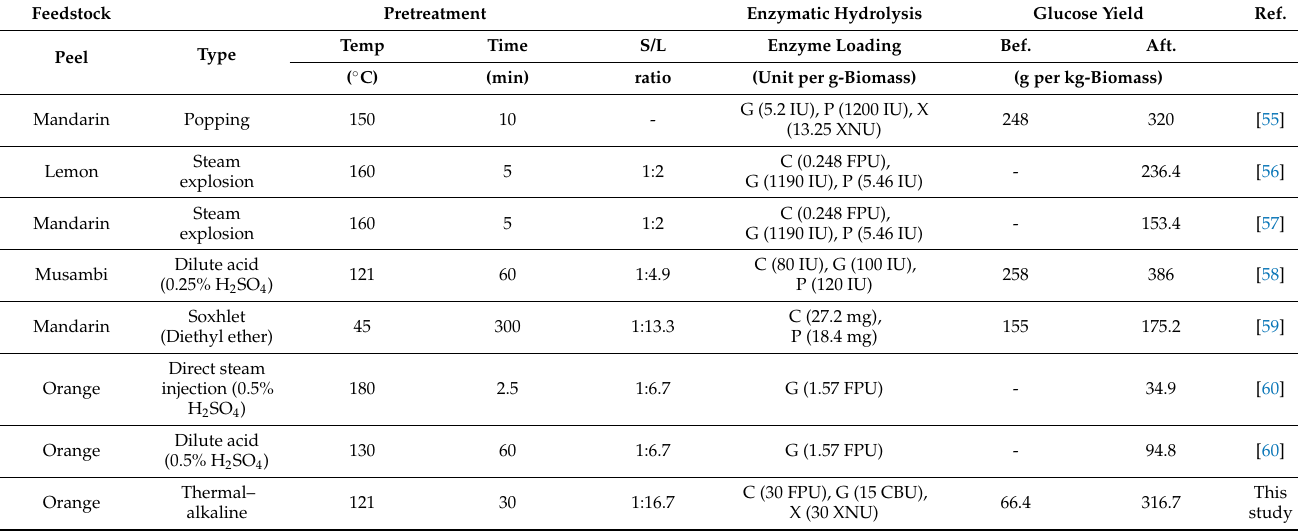
Table 7. Summary of the increase in glucose yield based on pretreatments and enzymatic hydrolysis. Feedstock Pretreatment Enzymatic Hydrolysis Glucose Yield Ref. Enzyme Loading Bef.